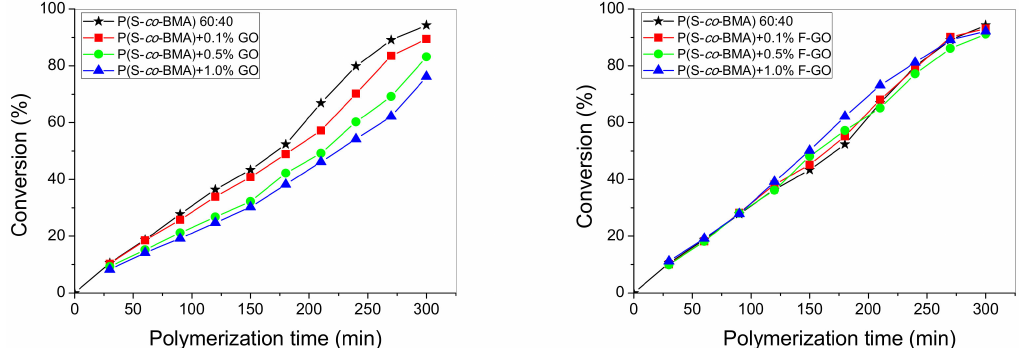
Figure 2. Variation of monomer conversion with polymerization time during bulk in-situ radical polymerization of styrene with n-butyl methacrylate, 60:40 at 80 ◦ C at various graphene oxide ( a ) or functionalized graphene oxide ( b ) contents.